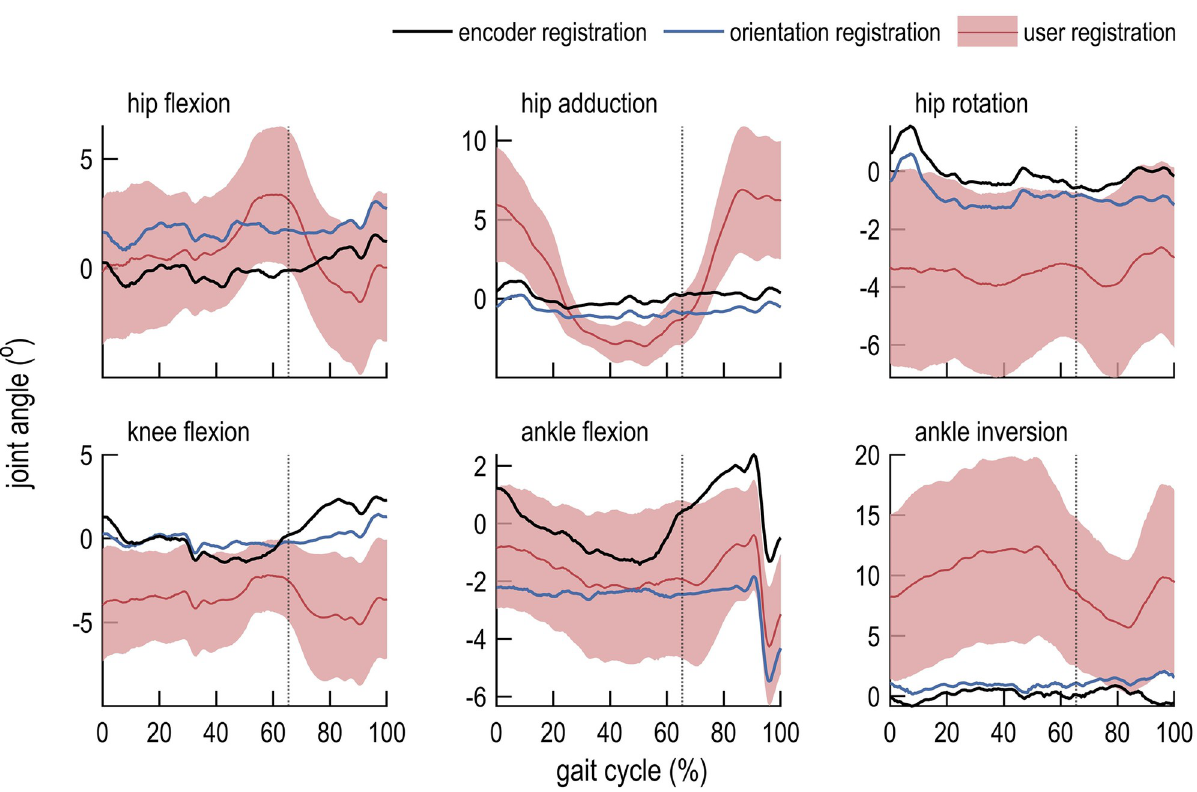
Fig 4. Errors in inverse kinematics calculations for each registration method. Errors in joint angles were computed relative to robot joint encoder data over one gait cycle using encoder registration (black line), orientation registration (blue line), and user registration (mean, red line; standard deviation, shaded). Toe-off is indicated by a dotted vertical